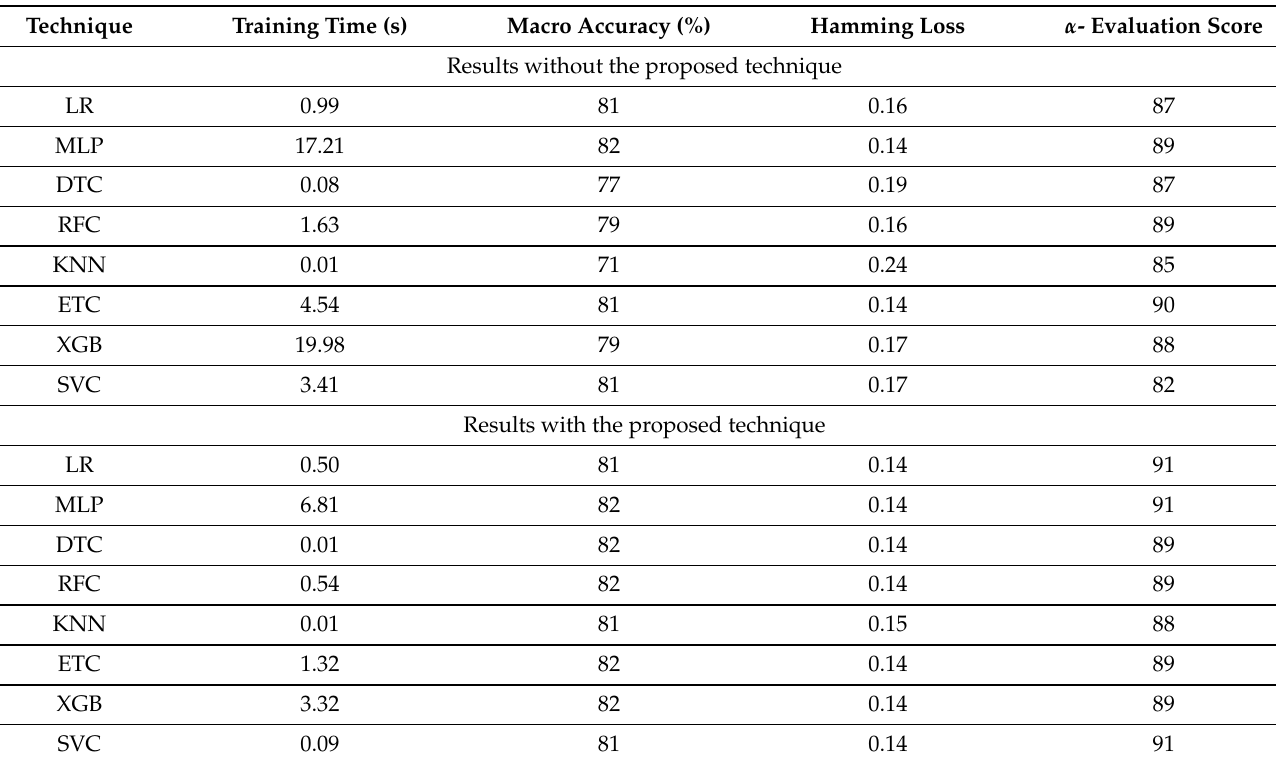
Table 13. The multi-label multi-class performance comparative analysis using balanced data with 80:20